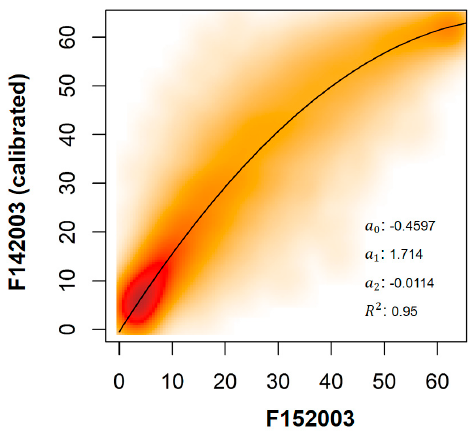
Figure 3. Relationship (and coefficients) of NTL DNs between calibrated F142003 (Step 1) and F152003.